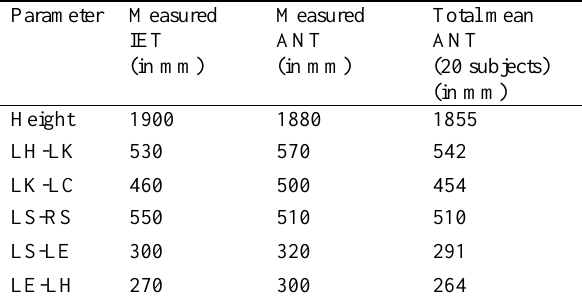
Table 1. Selected parameters: extraction technique (IET) vs. anthropometer